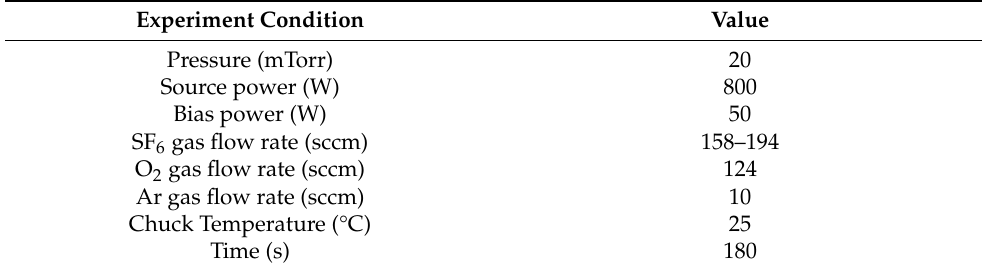
Table 2. Best-known method (BKM) process